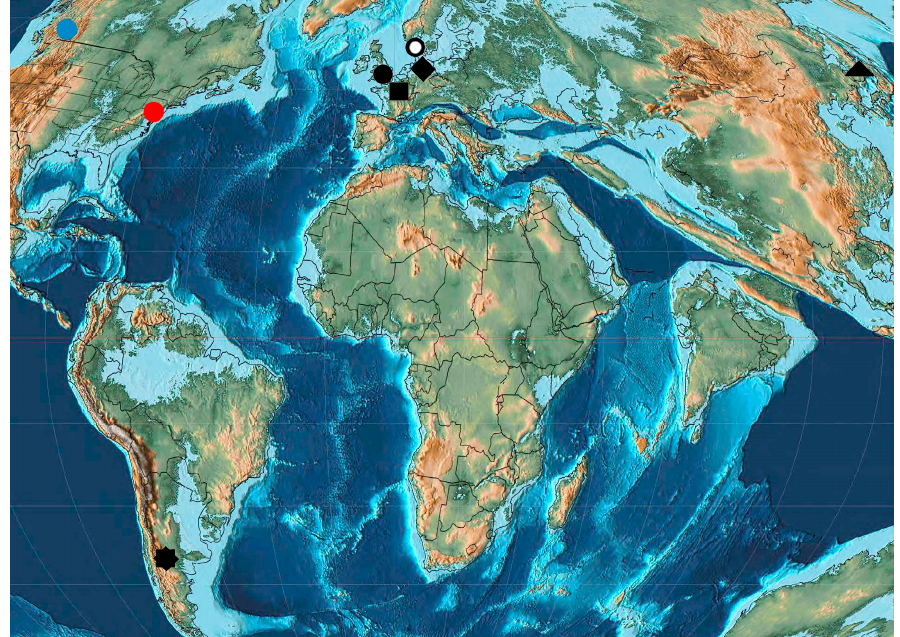
Figure 6. Early Eocene Curculionoidea deposits: square—Oise amber; circle—Peckham and London Clay; rhombus—Havighorst; ring—Mors; red circle—Republic; blue circle—Quilchena; triangle—Tadushi; octagon—Huitrera Formation. Table 1. Localities with Curculionoidea from the